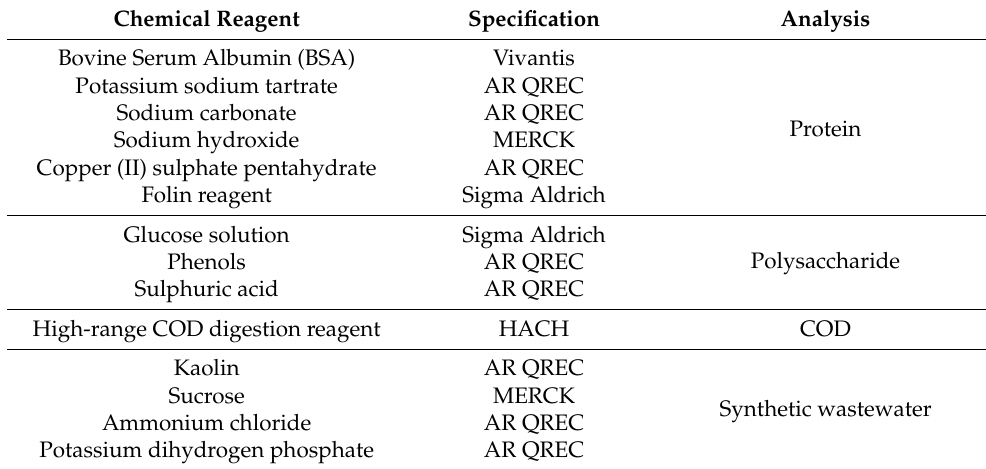
Table 1. Chemical reagents used for analysis.